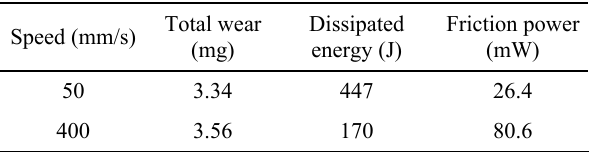
Table 1 Wear results for the experiments with the 5 µm slurry and after a sliding distance of 846 m.